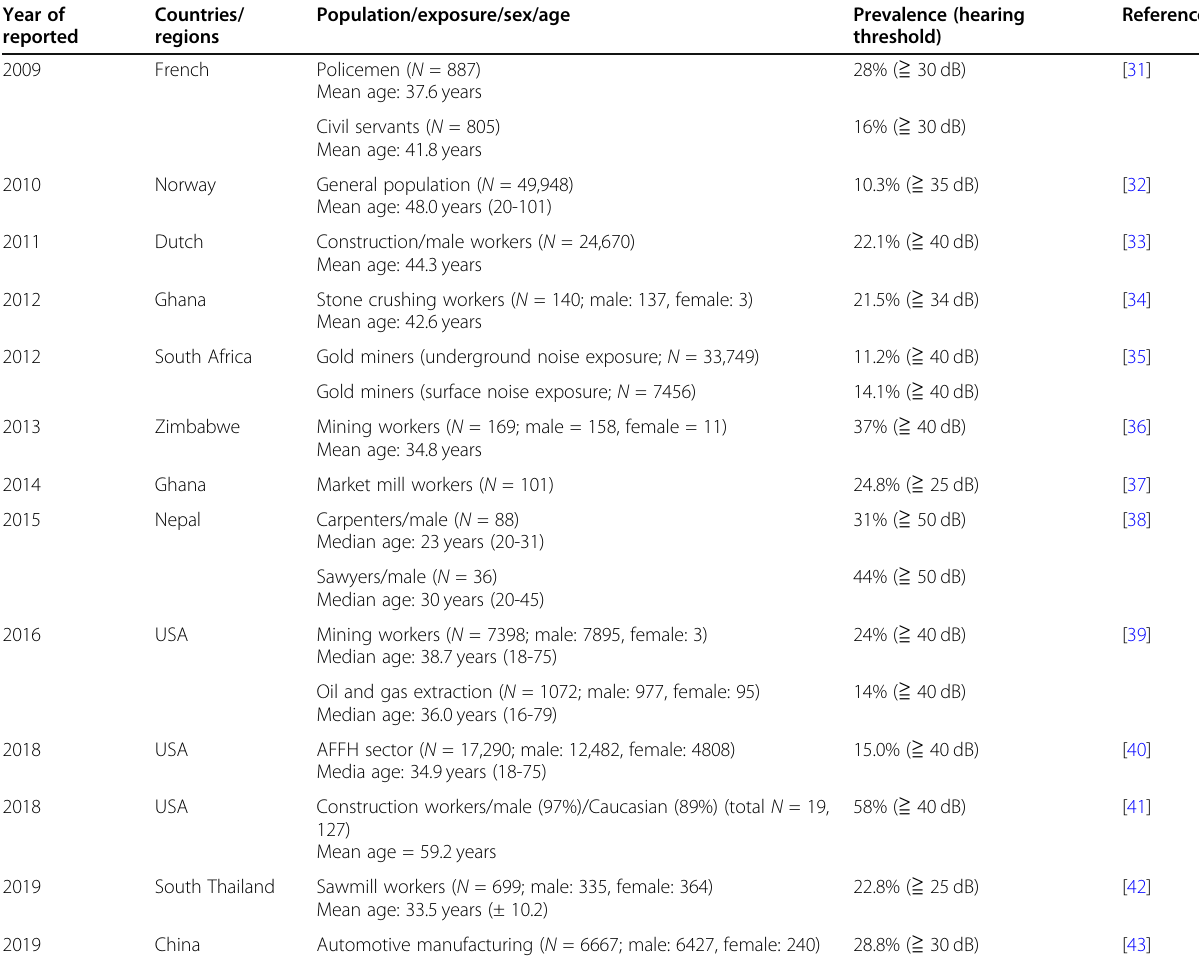
Table 1 A summary of the prevalence of noise-induced hearing loss among workers in the world by year reported by occupation by country,